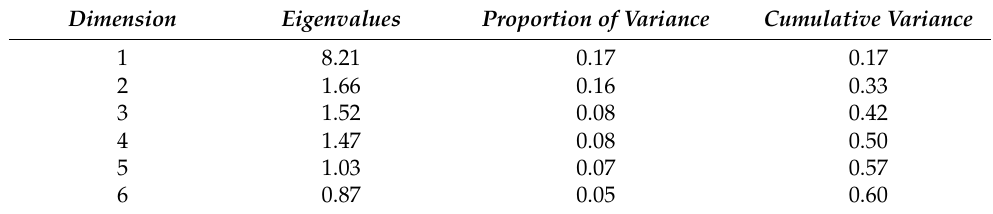
Table 4. Eigenvalues of the correlation